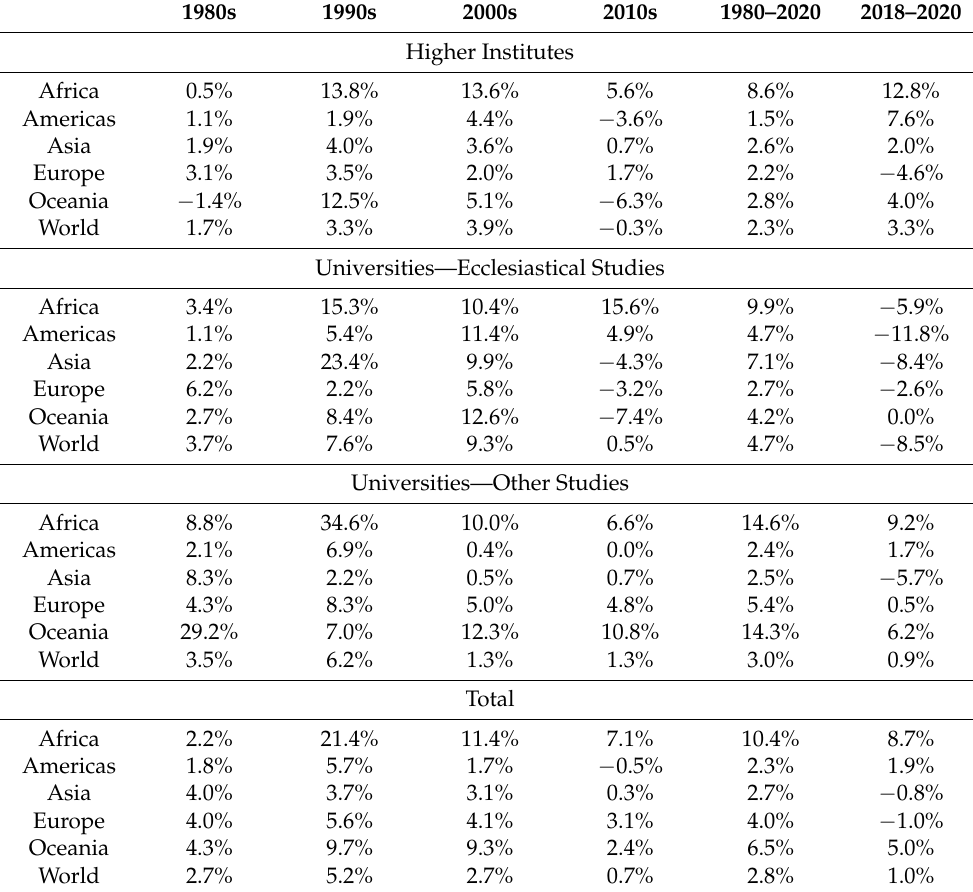
Table 3. Annual growth rate for enrollment in Catholic institutions of higher education